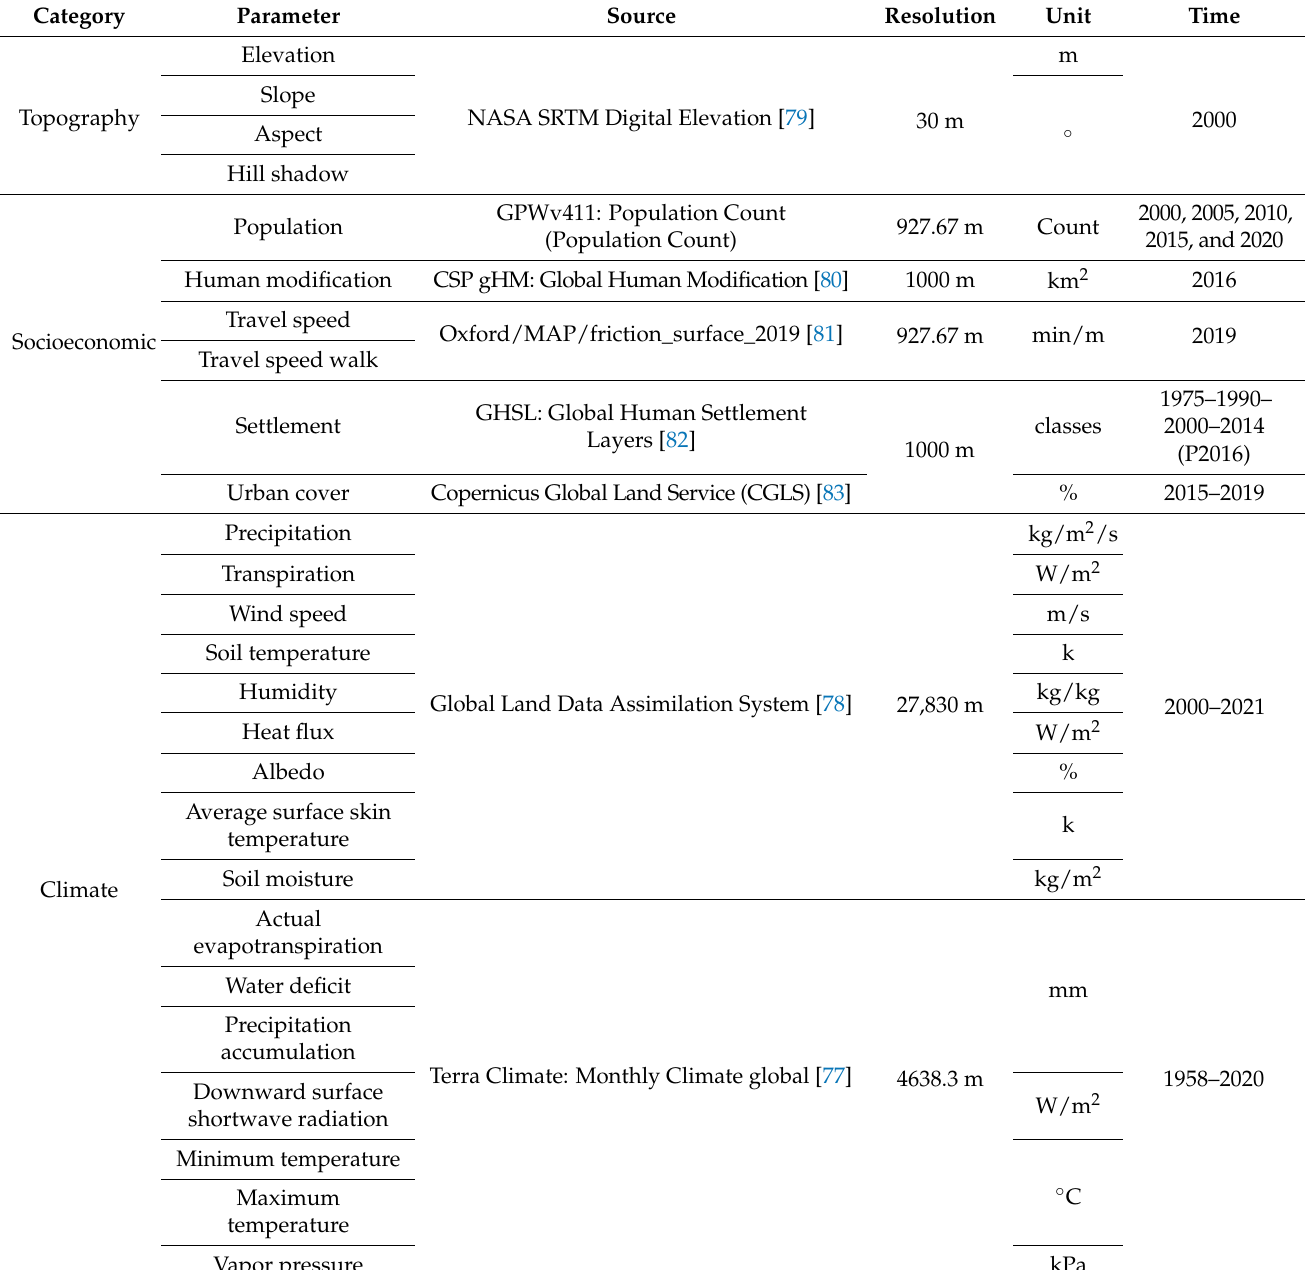
Table 1. List and description of the study’s variable datasets with source